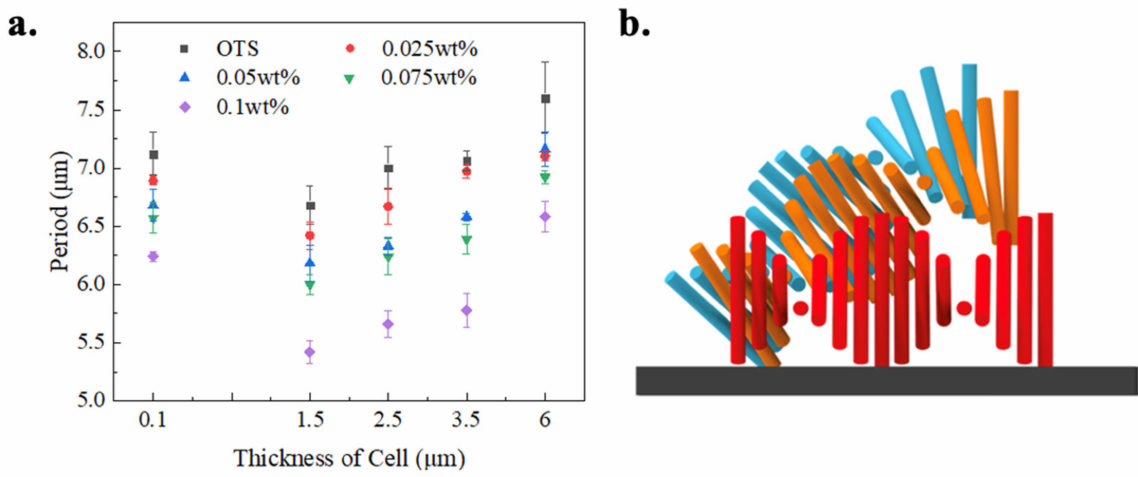
Figure 8. ( a ) Periods of long-range order stripes as function of PMMAZO brush solution concentration. The graft- ing densities of PMMAZO corresponding to the concentrations are 1.72 × 10 − 2 chains/nm 2 , 2.02 × 10 − 2 chains/nm 2 , 2.31 × 10 − 2 chains/nm 2 , 2.6 × 10 − 2 chains/nm 2 , respectively. ( b ) Illustration shows the degree of tilting of helix varies with surface anchoring. The red color schematic diagram represents CLC confined in OTS-modified cell with a long axis of helix parallel to the substrate. Orange and blue color schematics represent degrees of tilting of helices in cells with different grafting densities: Orange—lower grafting density and blue—higher grafting